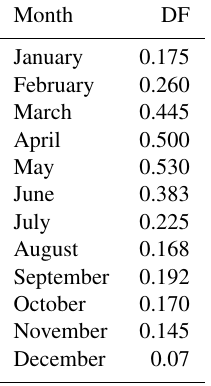
Table 1. Monthly mean SSA bromine depletion factor (DF) scheme applied in the NH ( > 45 ◦ N), which is derived from the data in the Southern Hemisphere at Cape Grim (41 ◦ S), Macquarie Island (55 ◦ S), and Dumont d’Urville (66 ◦ S; Ayers, 1999; Legrand et al., 2016). Note that a 6-month shift in the phase is applied to match the NH seasons. A cut-off dry NaCl diameter of 10µm is applied (i.e. DF = 0 at diameter >